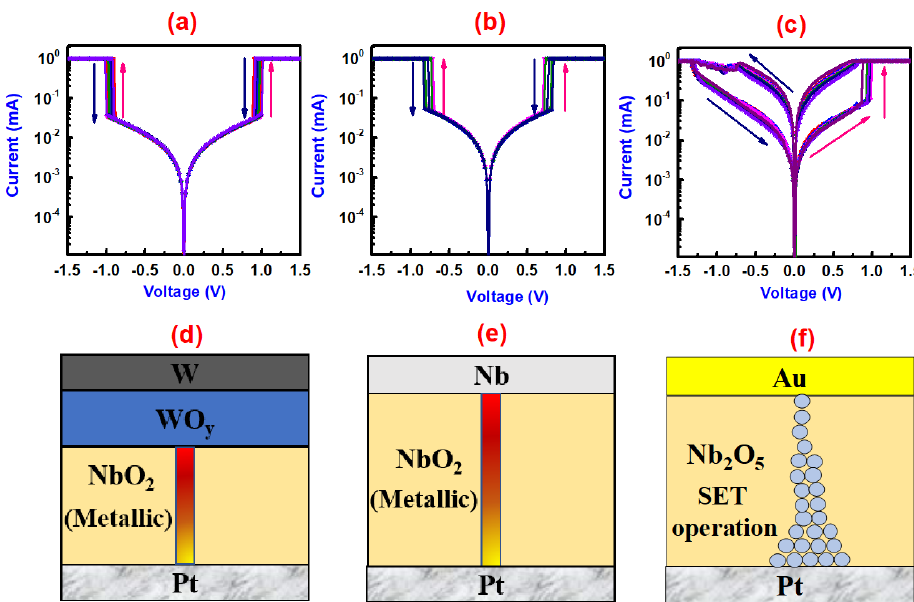
Figure 2. Electrical measurements of di ff erent top electrode (TE) devices ( a ) W / NbO x / Pt stack, ( b ) Nb / NbO x / Pt stack and ( c ) Au / NbO x / Pt stack. Schematic diagrams of SET operation of di ff erent TE